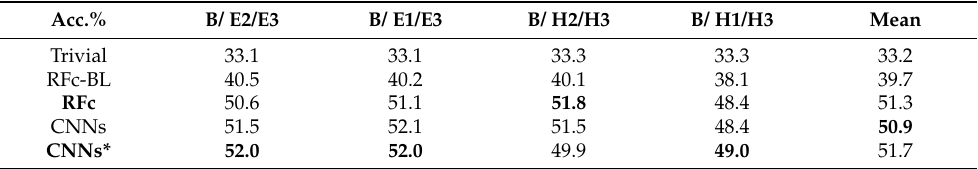
Table 5. Recognition approaches accuracy results of phasic stimuli 3-class classification task, the meaning of abbreviations is provided by the list in abbreviations